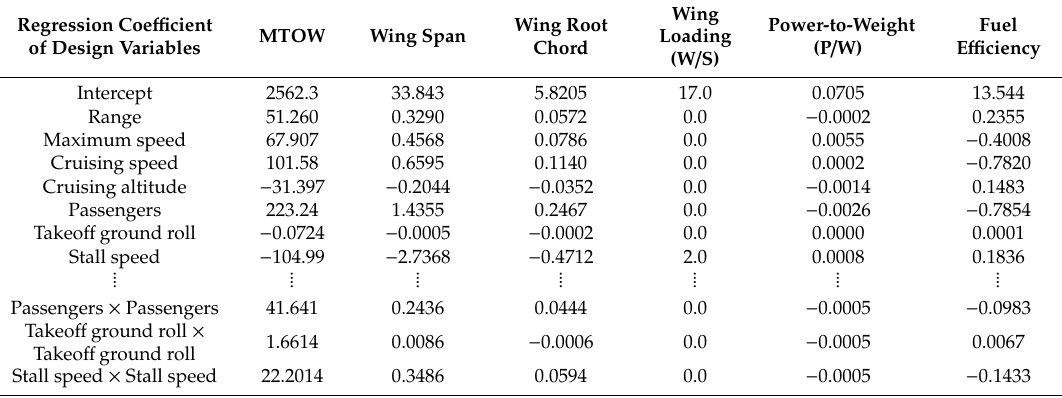
Table 4. Regression coefficients of a response surface model.